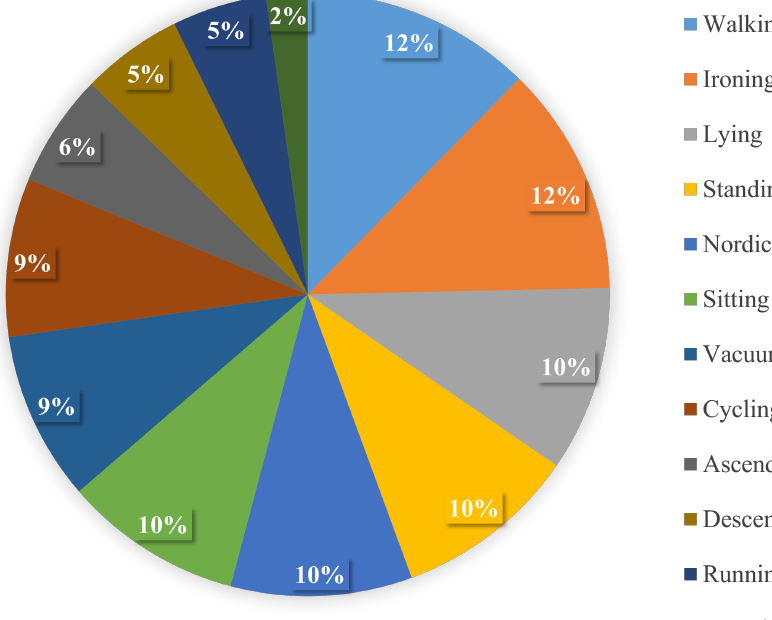
Figure 3. Activity distribution of the PAMAP2 dataset.